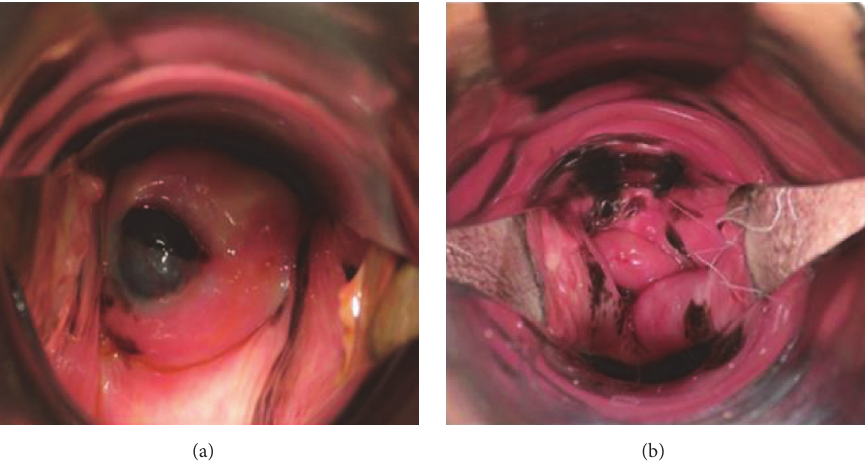
Figure1:Macroscopicfindingsdemonstrateda2 cmpolypoidblackish-pigmentedtumorinthecervix(a).Multiplesmallblackish-pigmented tumors throughout the vaginal wall spreading to the lower third of the vagina (b).